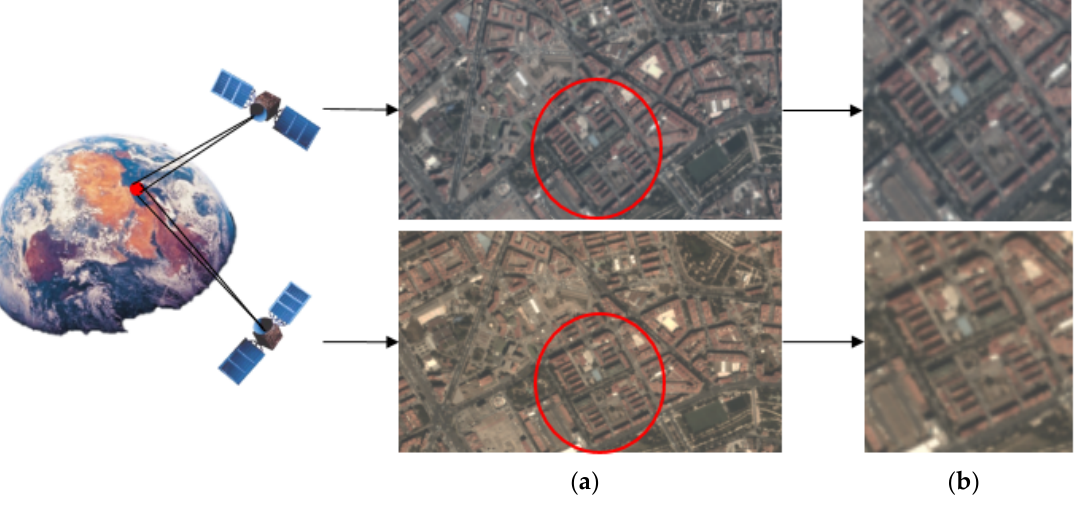
Figure 1. Appearances of two video clips shot of the same location at different time by two different satellites. ( a ) A sample frame taken from each of the video clips; the same structure indicates the same location. ( b ) Magnified area showing the variances in projection, color, and quality.